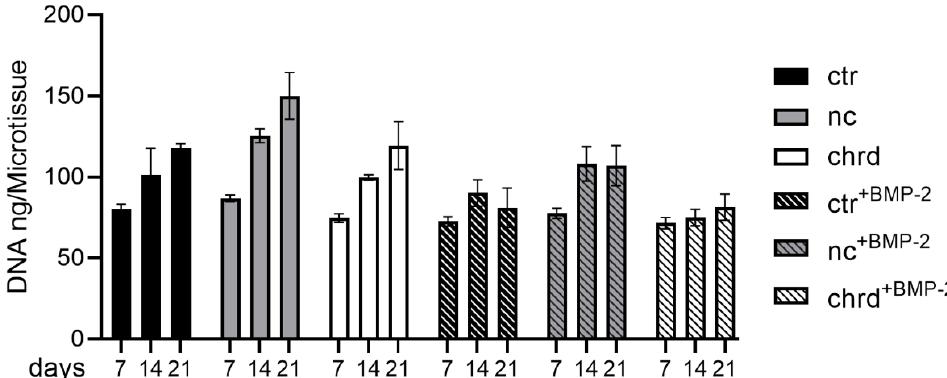
Figure 3. DNA content after 7, 14, and 21 days in microtissues assembled from siRNA-loaded cGM and hMSC cultured in osteogenic medium with or without BMP-2 (ctr: non-treated control, nc: non-coding siRNA, chrd: chordin siRNA). Table 3. Proliferation rates (increase DNA in ng per day) in microtissues from siRNA-loaded cGM and hMSC in an osteogenic medium with or without BMP-2 (ctr: non-treated control, nc: non-coding siRNA, chrd: chordin siRNA).